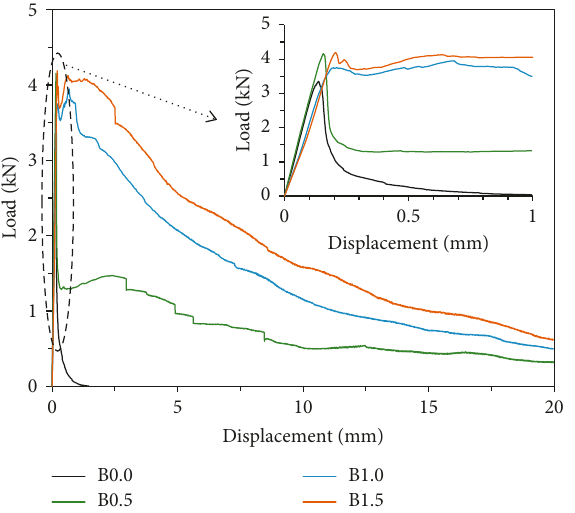
F and (b) characteristic length L ch .